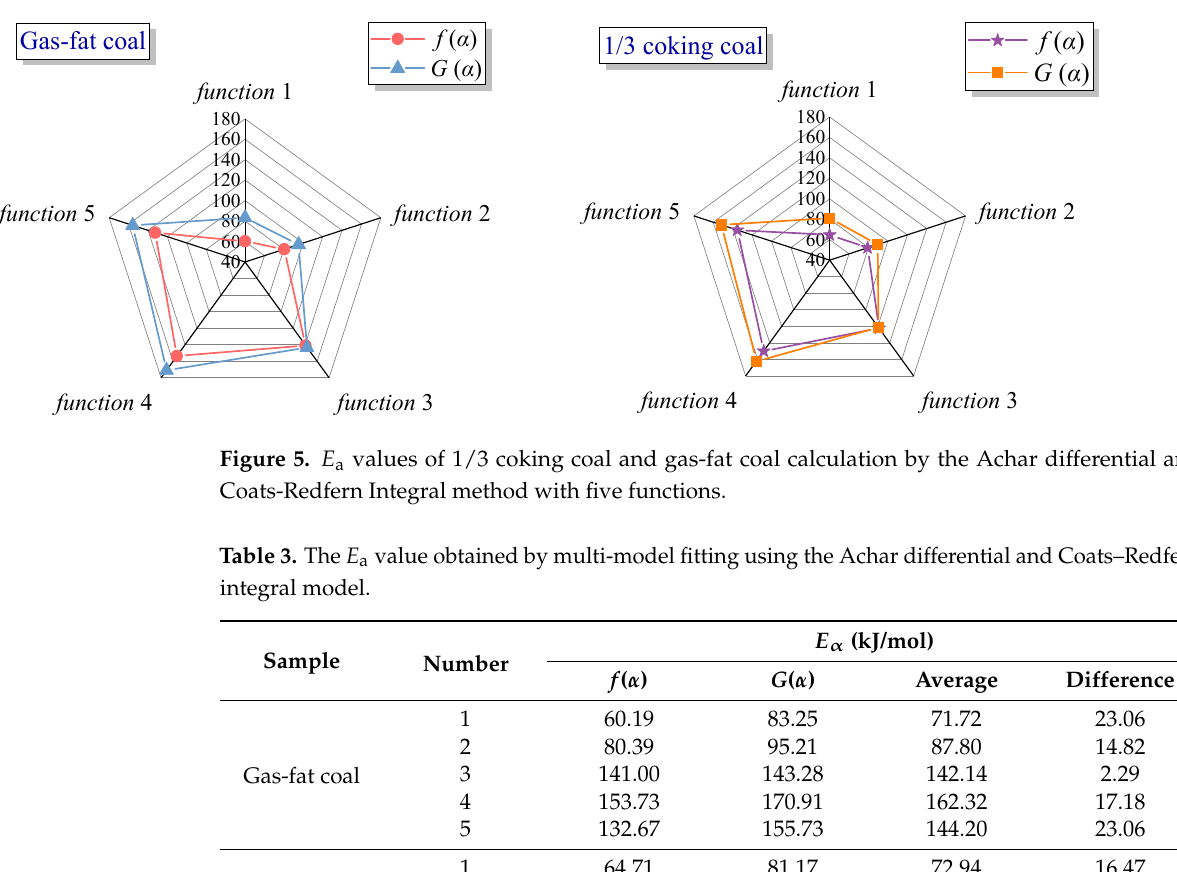
Figure 4. Fitting results for 1/3 coking coal and gas-fat coal. ( a ) 1/3 coking coal fitting by f ( α ); ( b ) 1/3 coking coal fitting by G ( α ); ( c ) Gas-fat coal fitting by f ( α ); ( d ) Gas-fat coal fitting by G ( α ).